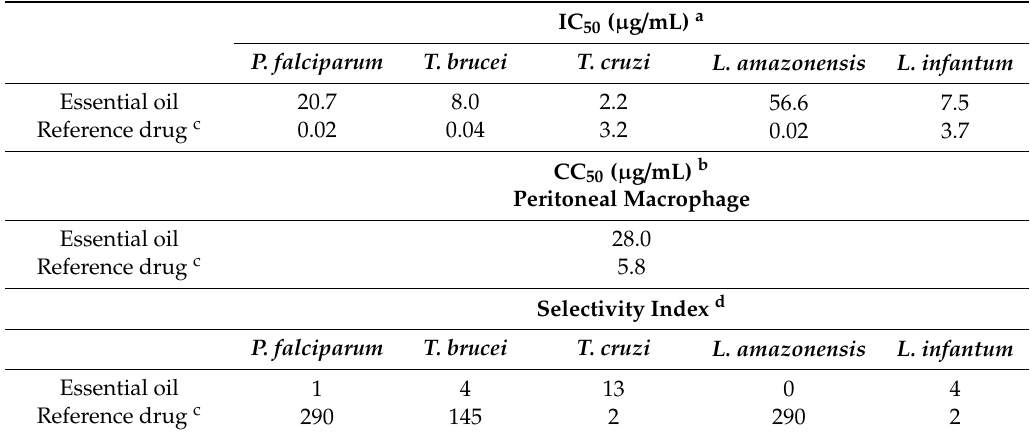
Table 2. Antiprotozoal activity and cytotoxic e ff ects of essential oil extracted by hydrodistillation from P. matricarioides collected in Bauta municipality, Artemisa, Cuba.